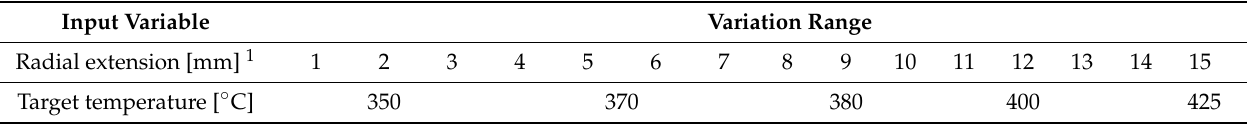
Table 2. Input variables definition and delimitated range of corresponding values.